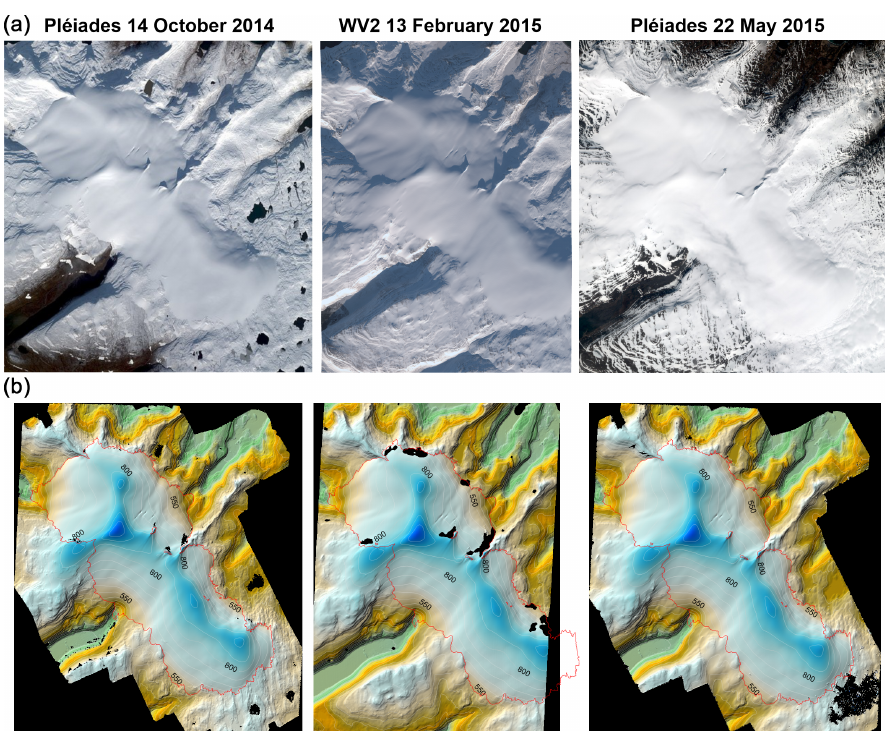
Figure 2. (a) Quickview (left image from each stereo pair) of the satellite images used. ©CNES 2014 and 2015, Airbus D&S, all copyrights reserved (Pléiades), and ©DigitalGlobe (WV2). Quickviews downloadable at http://www.intelligence-airbusds.com/en/ 4871-browse-and-order (Pléiades) and https://browse.digitalglobe.com (WV2). (b) The DEMs produced from each stereo pair, processed using scheme B, represented as a color hillshade with 50m contours overlaid (elevation in meters above ellipsoid WGS84). A red polygon delineates the ice cap. Black colors indicate no data in the